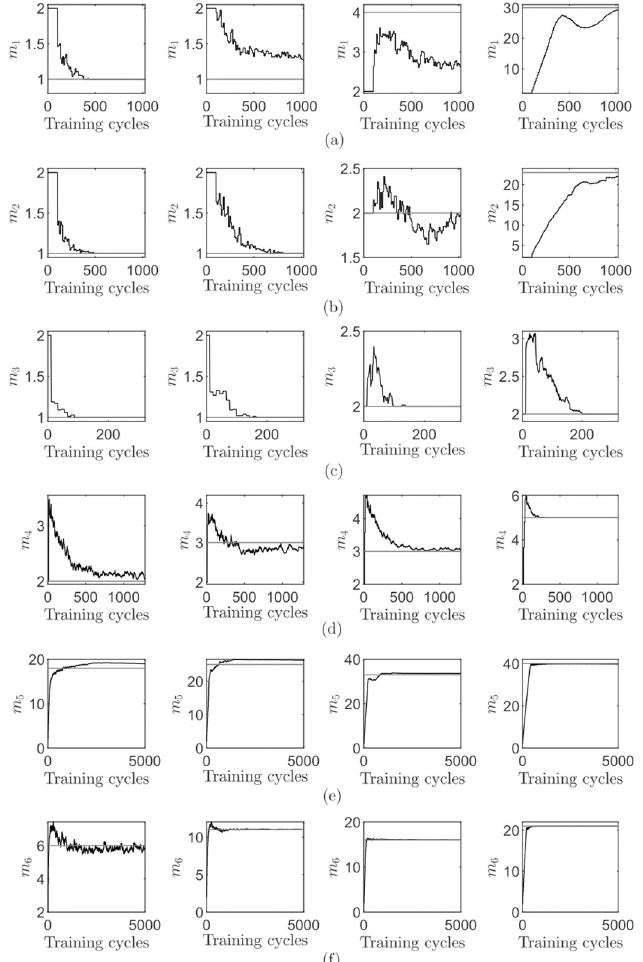
Fig 8. Visualization of the results achieved with the online cumulative percentage of total variance criterion. The first plot in each row has a proportion of θ 1 = 0.70, the left-middle plot of θ 2 = 0.80, the right-middle plot of θ 3 = 0.90 and the right plot of θ 4 = 0.99: (a-f) shows the results obtained on each data set, with a data set order corresponding to Table 5. Each data point in each time series is the mean value of all 100 repetitions. The horizontal reference line represents the optimal